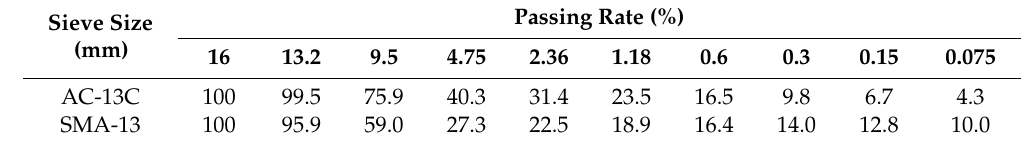
Table 5. Gradation of